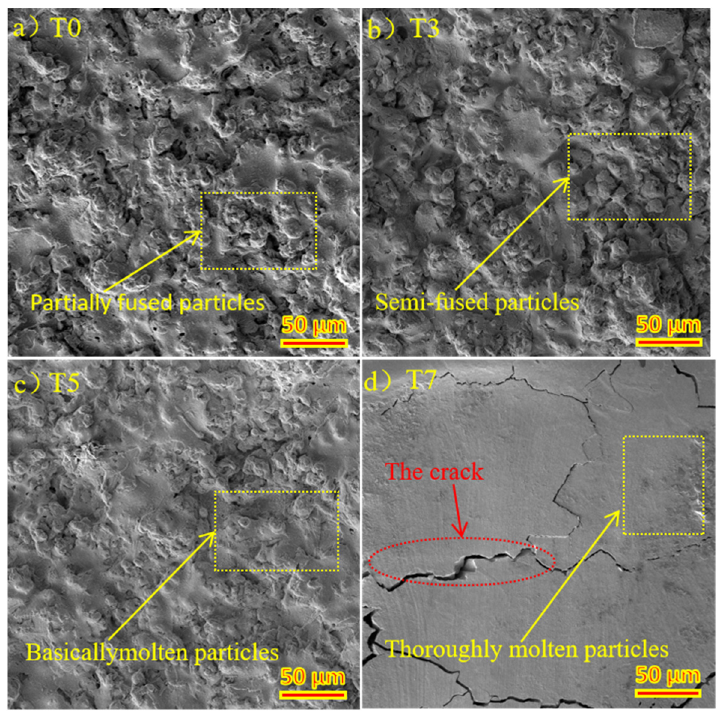
Figure 6. ( a ) The surface EDS of (T5); ( b ) The section EDS of (T5); ( c ) The section SEM of (T6); ( d ) The section SEM of (T8).